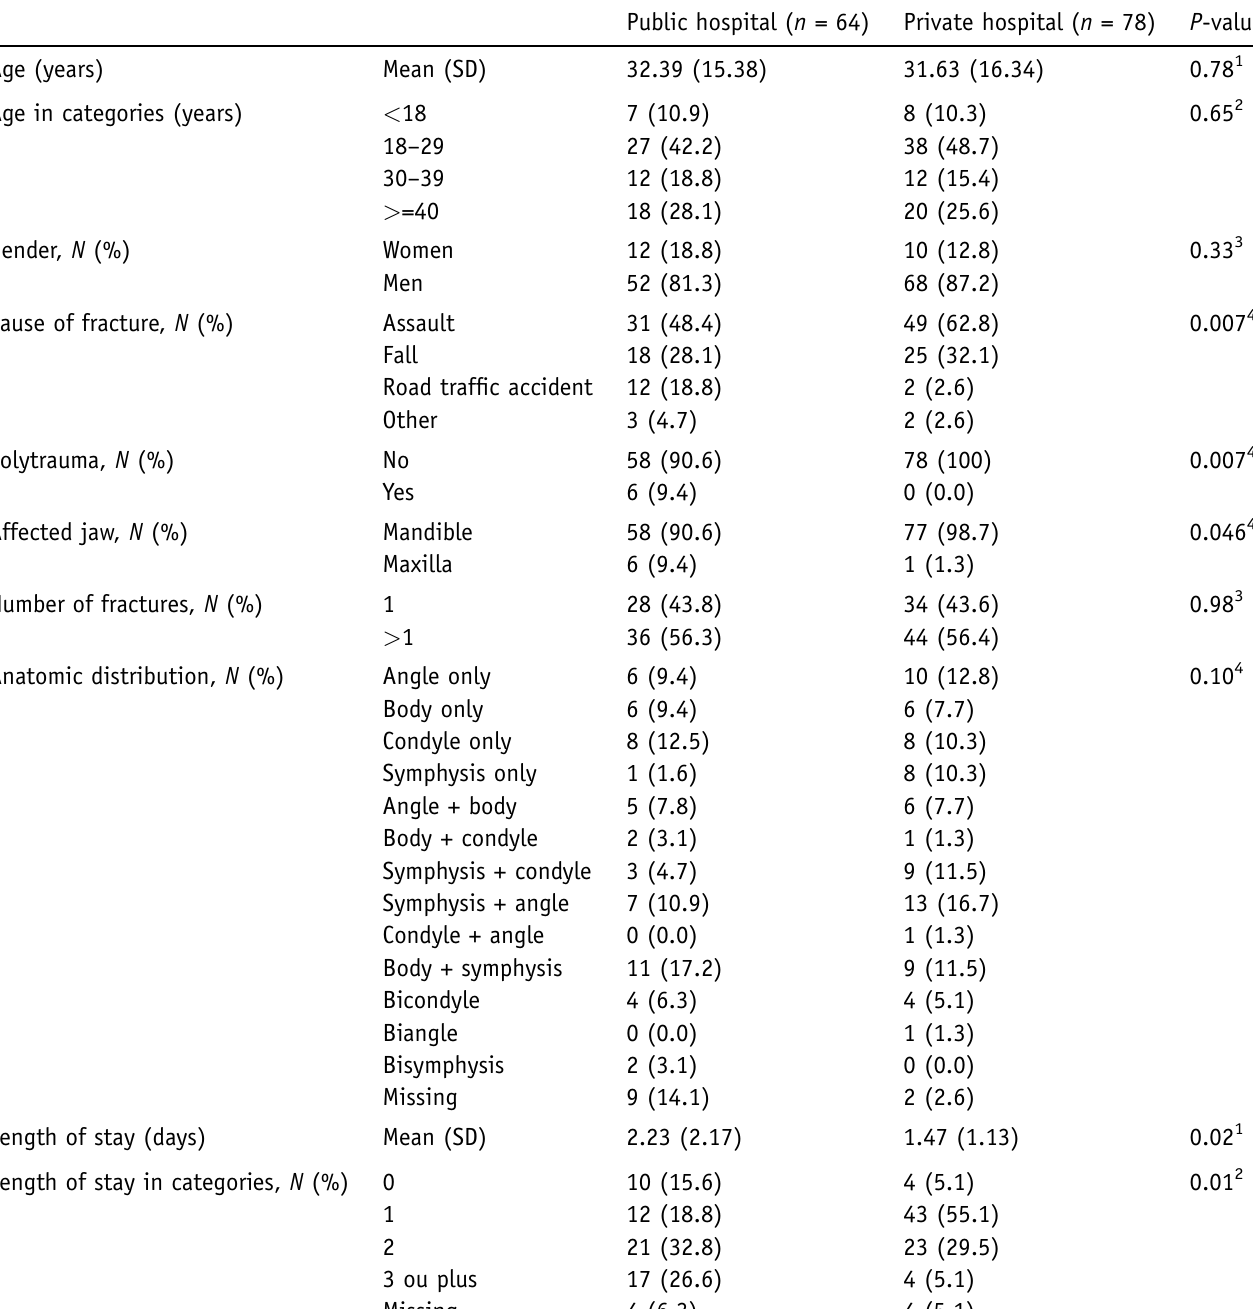
Table II. Description of patients ’ characteristics and of jaw fractures according to types of